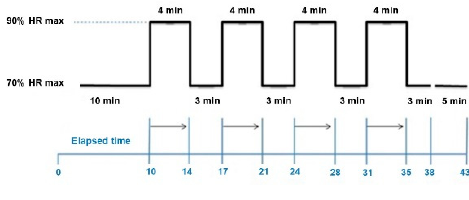
Figure 1. Training protocol.